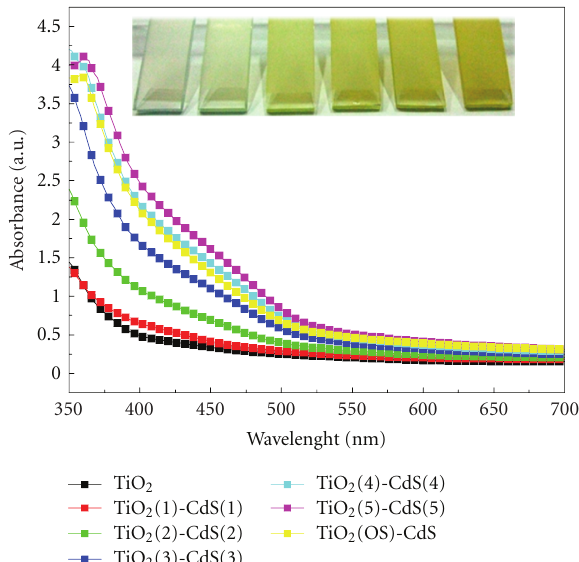
Figure 3: UV-vis absorption spectra of bare TiO 2 nanocrystalline film, TiO 2 ( n )-CdS( n ) ( n = 1–5) and TiO 2 (OS)-CdS electrodes. Photographs of bare TiO 2 and TiO 2 ( n )-CdS( n ) ( n = 1–5), electrodes were presented in turn as